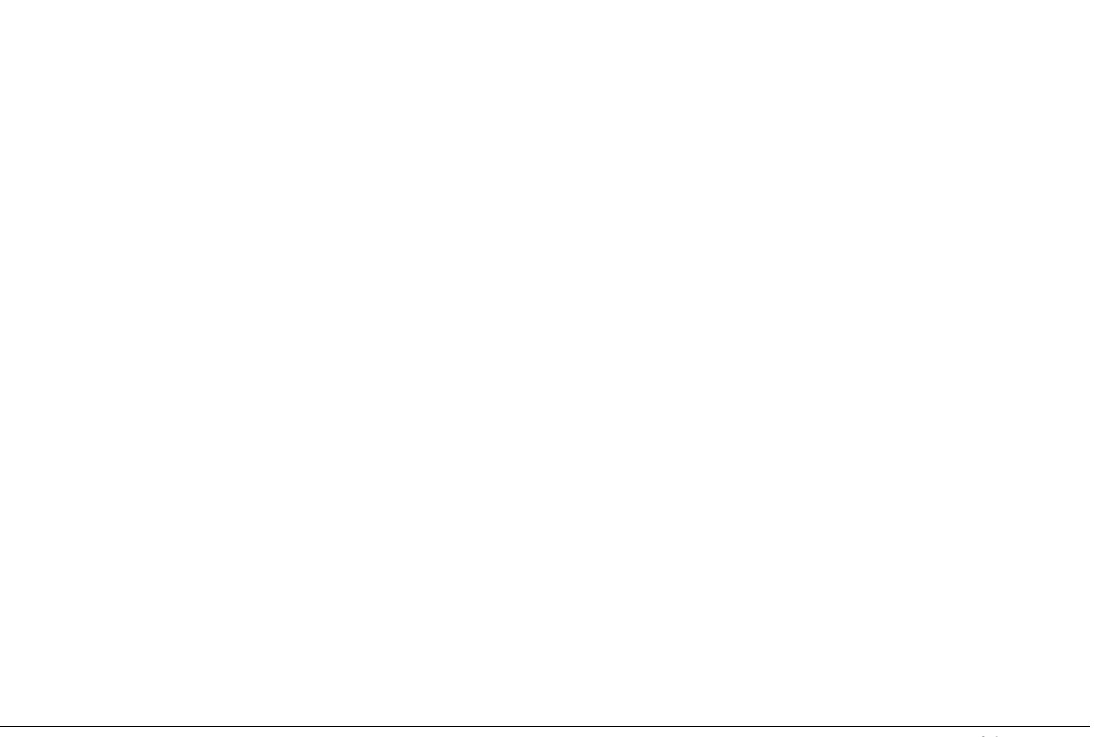
Figure 6. ( a ) F ′ (ξ) , ( b ) G (ξ) and ( c ) θ(ξ) with diverse φ